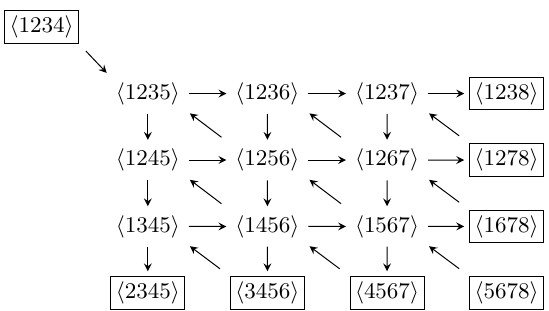
Figure 18. A cluster containing the poles of [12345] in Conf 8 ( P 3 ).